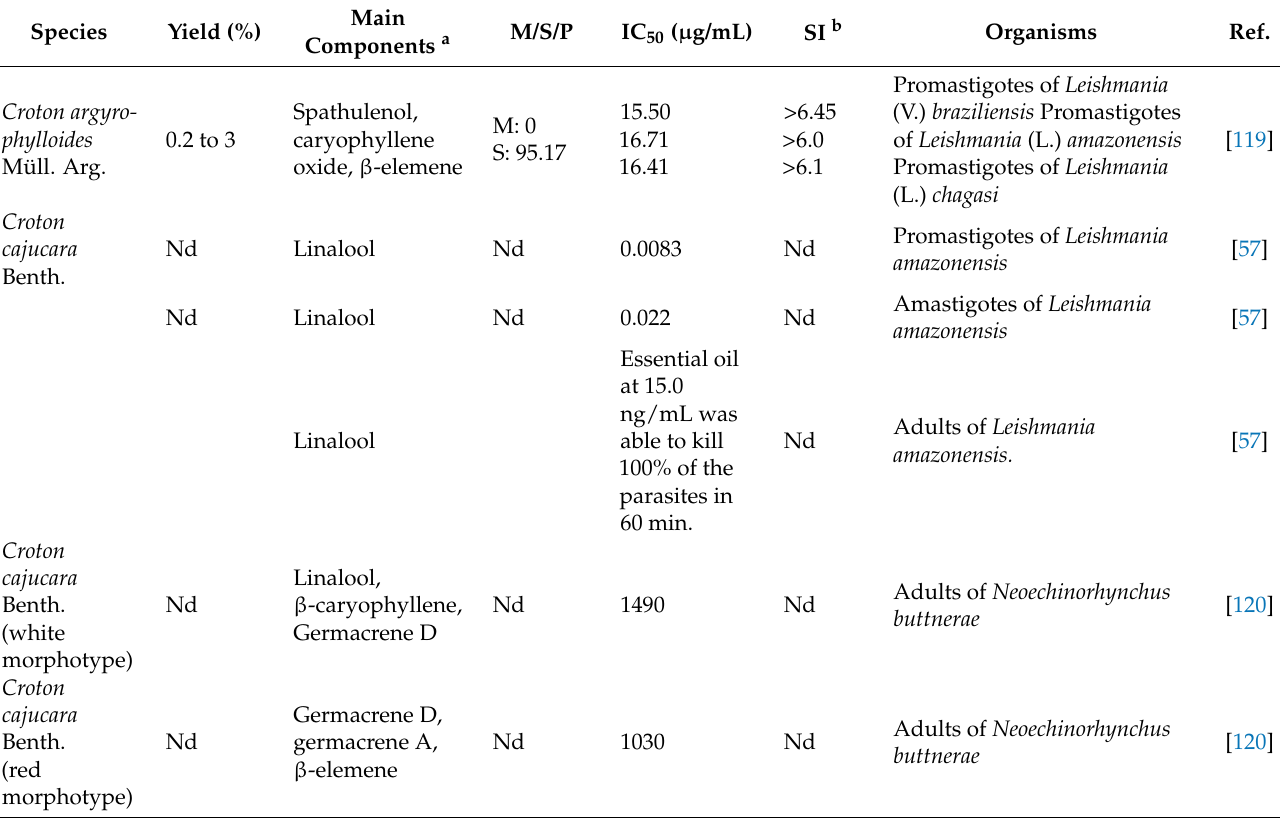
Table 7. Summary of antiparasitic activities of Croton spp. essential